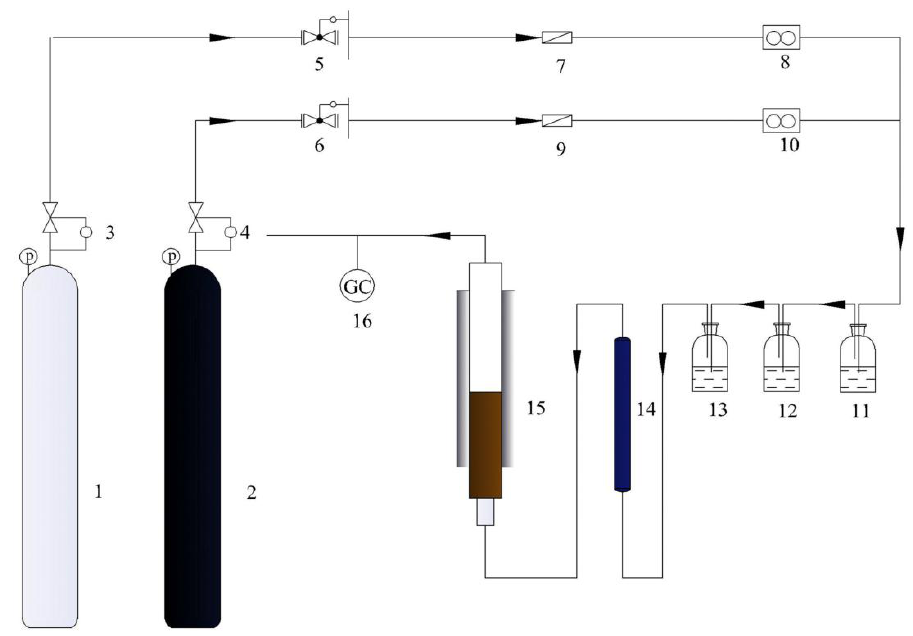
Figure 11. Schematic diagram of the C 2 H 2 dimerization system: 1 C 2 H 2 ; 2 N 2 ; 3 , 4 partial pressure valve; 5 , 6 check valve; 7 , 9 gas filter; 8 , 10 mass flow controller; 11 K 2 Cr 2 O 7 solution; 12 Na 2 S 2 O 4 solution; 13 NaOH solution; 14 drying tube; 15 reactor; 16 Gas Chromatograph (GC-2014C).